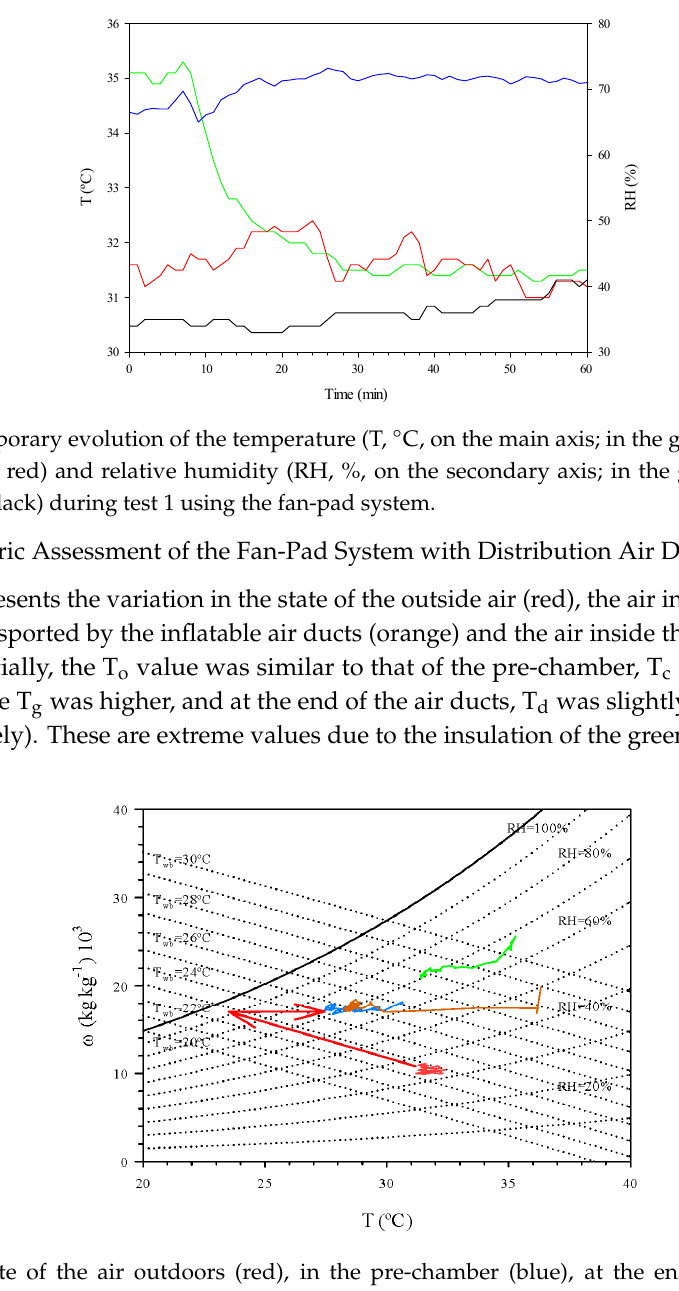
Table 2. The average values and standard deviation of the different operating parameters for the fan-pad system in test 1.